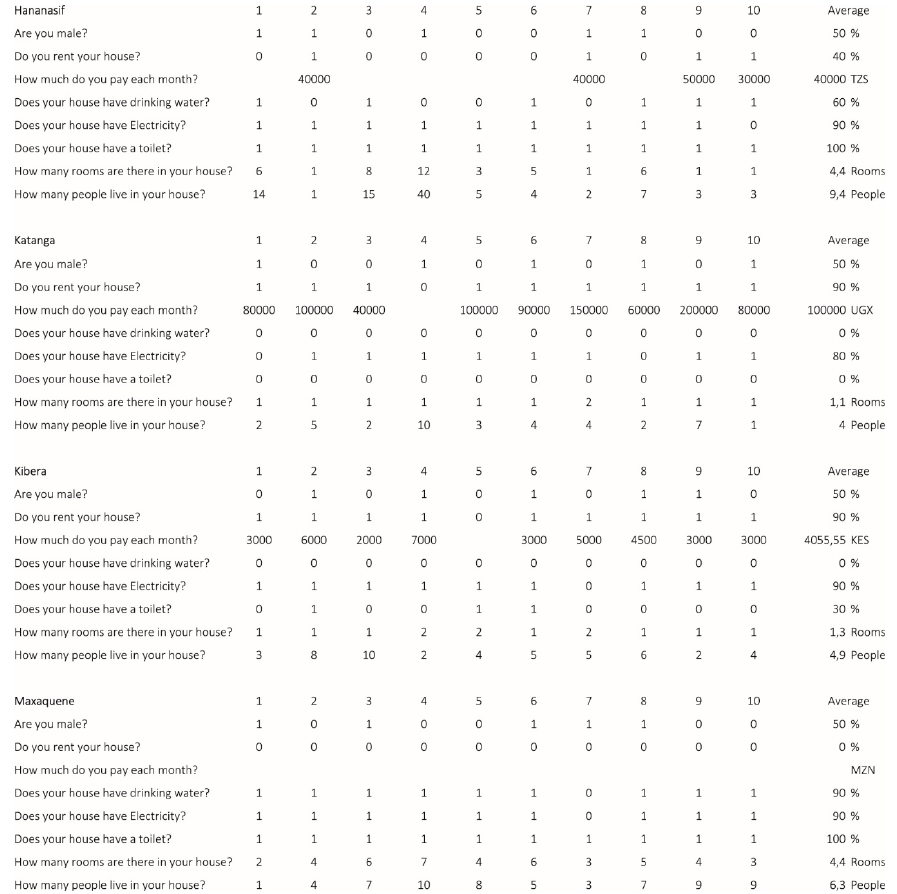
Figure A1. Full interview data. The interviewees are numbered horizontally to the right of the neighborhood name with responses for each question underneath. The responses to the binary (yes/no) questions are assigned 1 for yes and 0 for no.